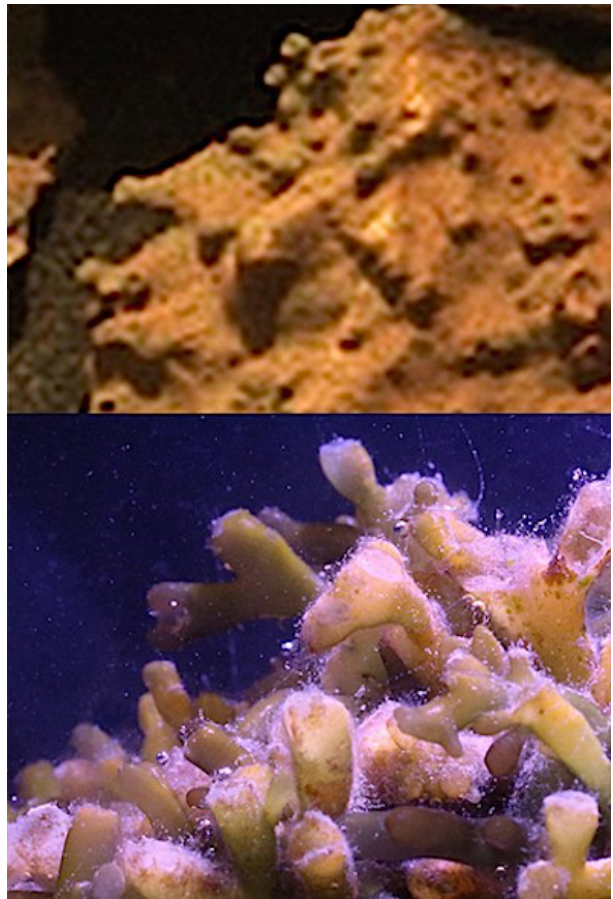
Figure 12. (Top) Sol 232: Specimens similar to gas-vent apertures for the release of oxygen secondary to photosynthesis within microbial mats; photographed in Gale Crater. (Bottom) Cone-like tubes for the venting of oxygen produced by photosynthesizing algae (reproduced with permission from Freeman SE, Freeman LA, Giorli G, Haas AF (2018) Photosynthesis by marine algae produces sound, contributing to the daytime soundscape on coral reefs. PLoS ONE 13(10): e0201766).